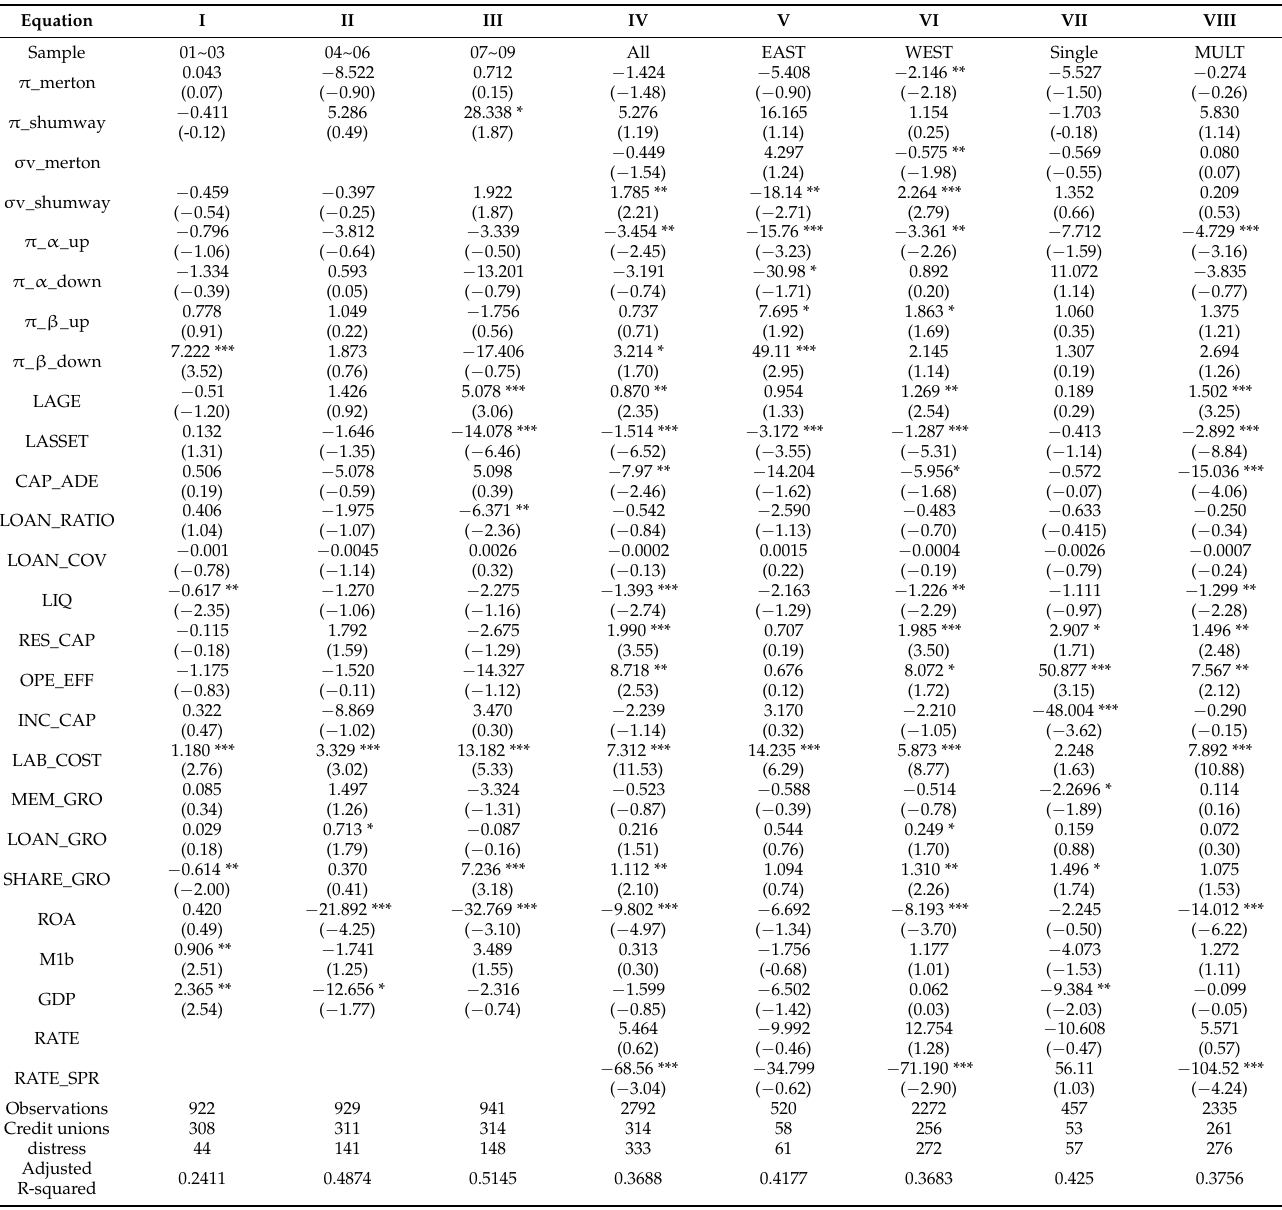
Table 6. Hazard function estimation